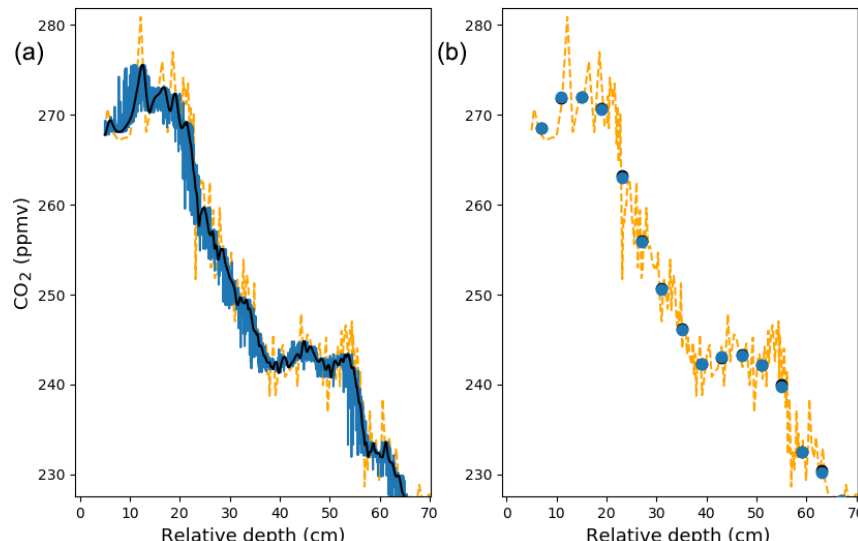
Figure 12. Impacts of layered trapping and smoothing on a synthetic 1.5-million-year-old carbon dioxide record. (a) Recorded signal in the ice taking into account smoothing (in black) and layered trapping artifacts (in blue). The signal without smoothing or artifacts is shown in orange. (b) Measured signal by a discrete system shown as blue points. The signal without smoothing or artifacts (in orange) and the measured signal without layering artifacts (black points) are also displayed. The depth scale is expressed relative to an arbitrary point in the record and in centimeters.